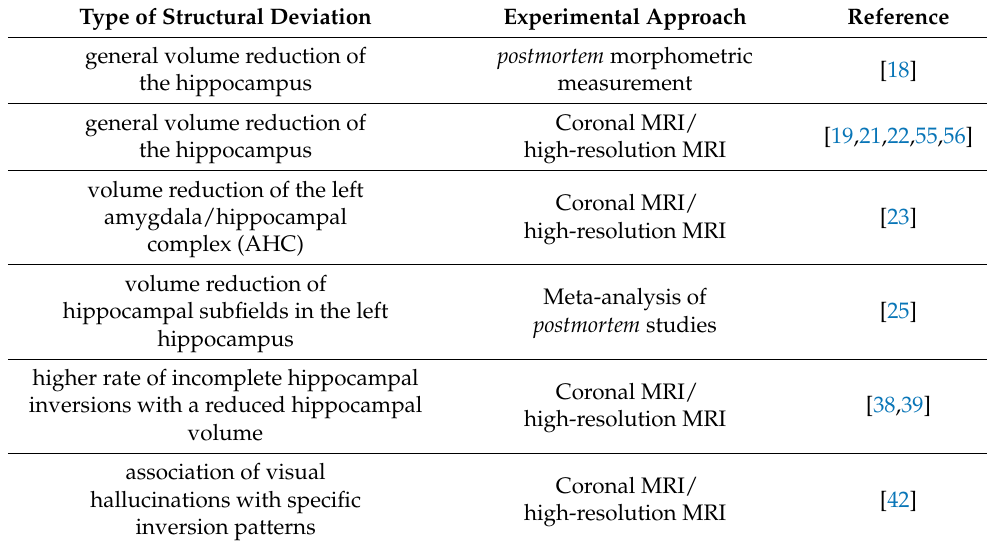
Table 1. An overview on the structural abnormalities of the hippocampus in schizophrenia